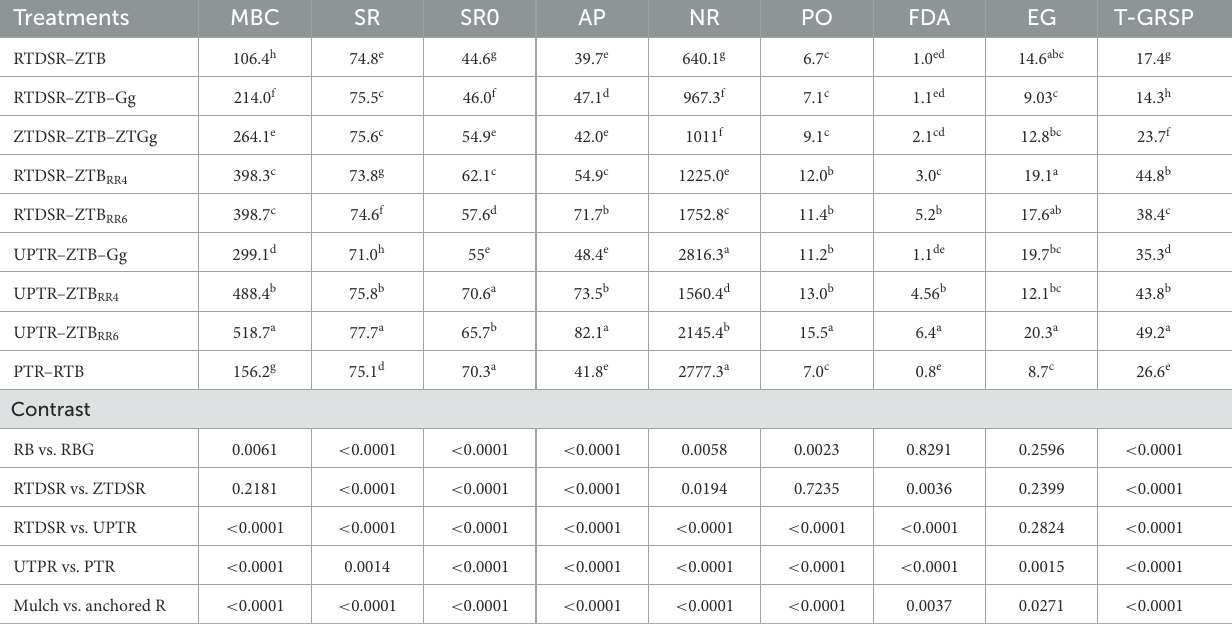
TABLE 3 Effect of tillage and residue management practices on soil biological